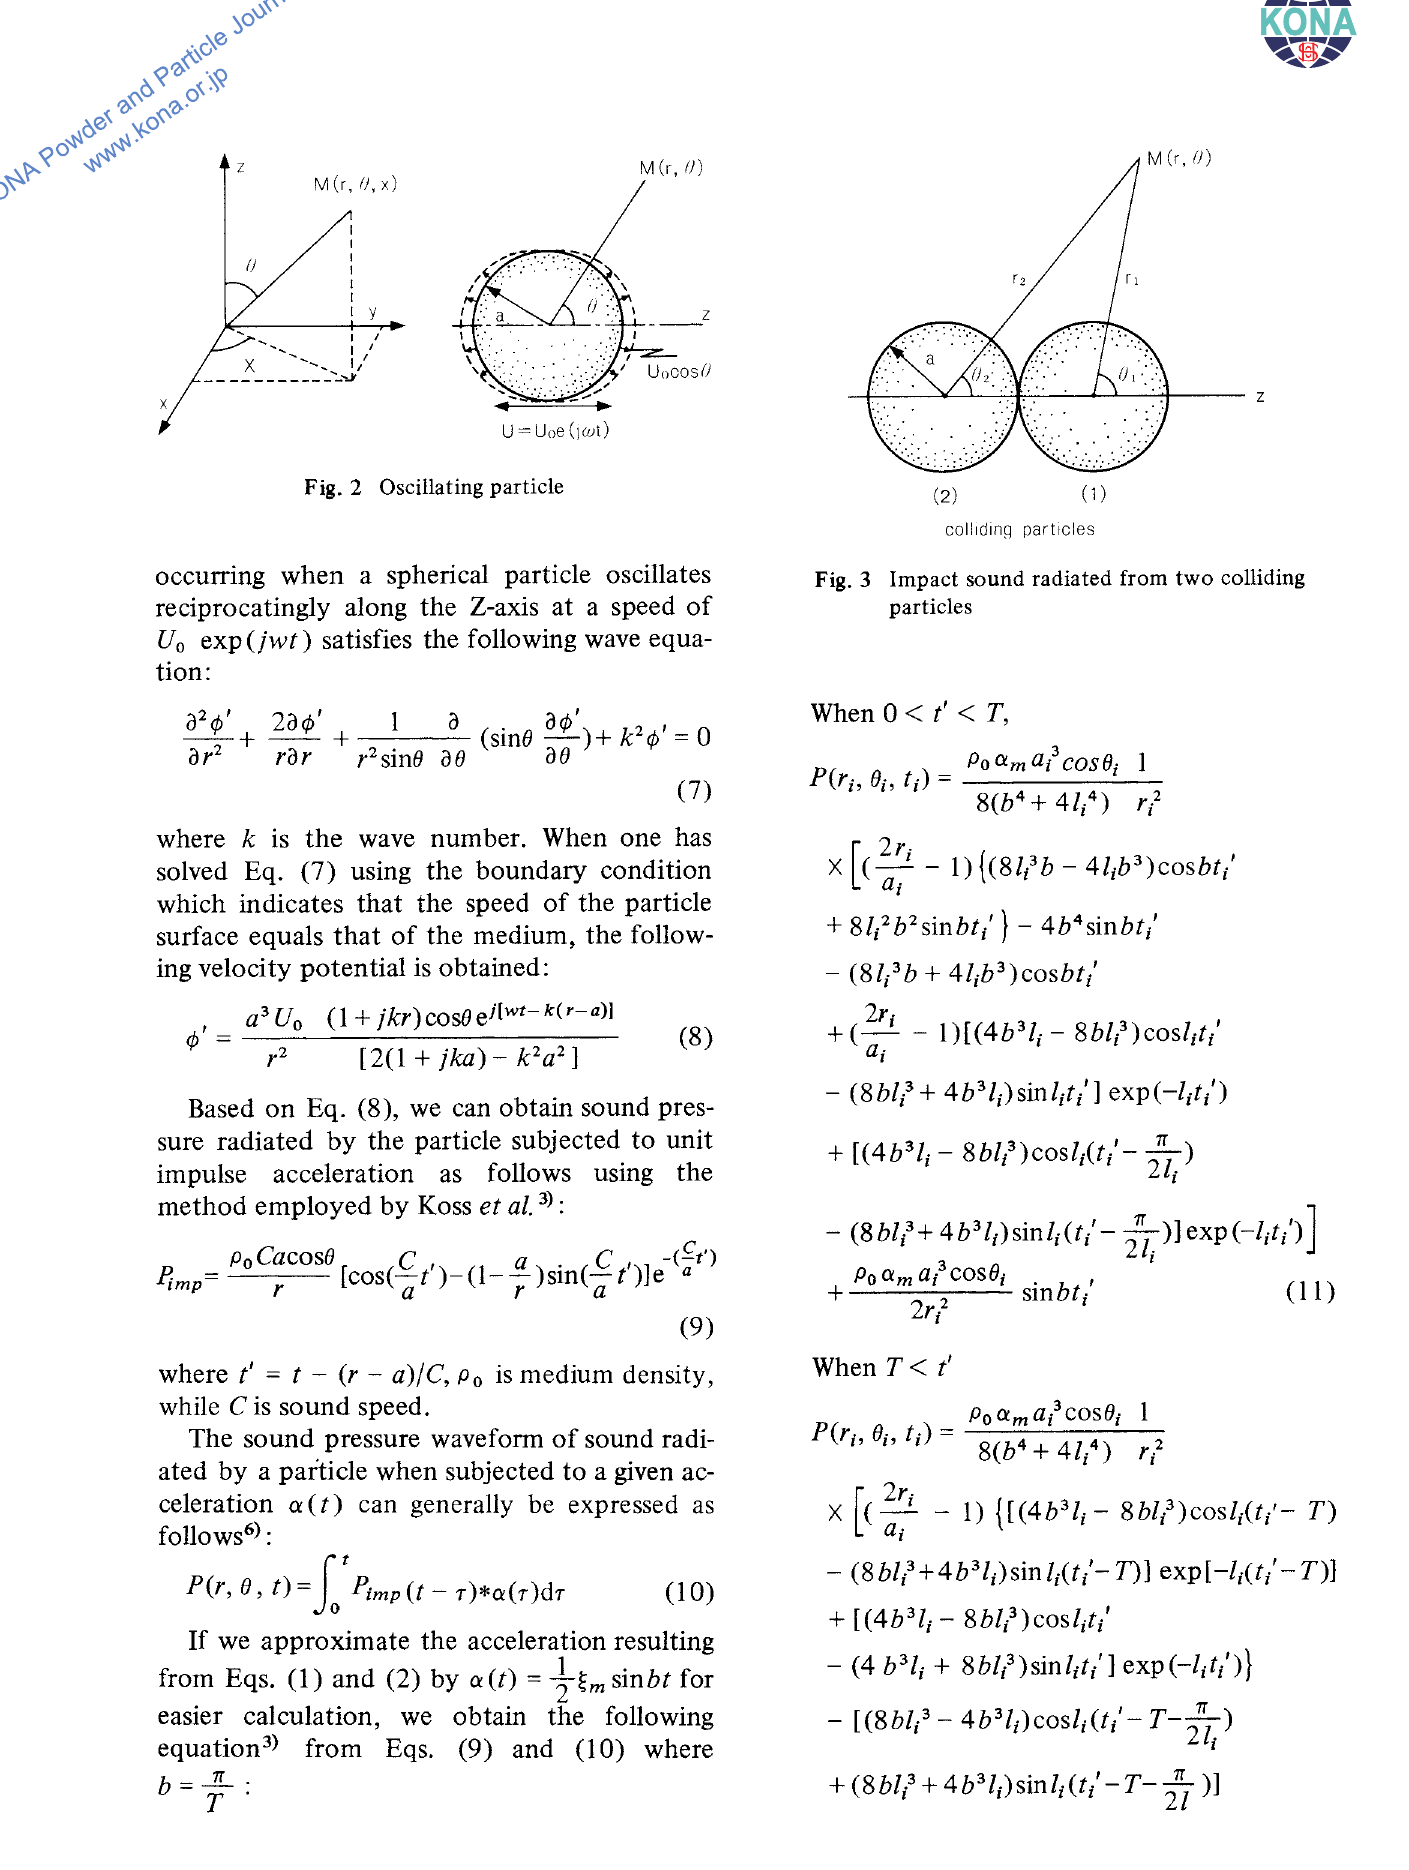
Fig. 2 Oscillating particle